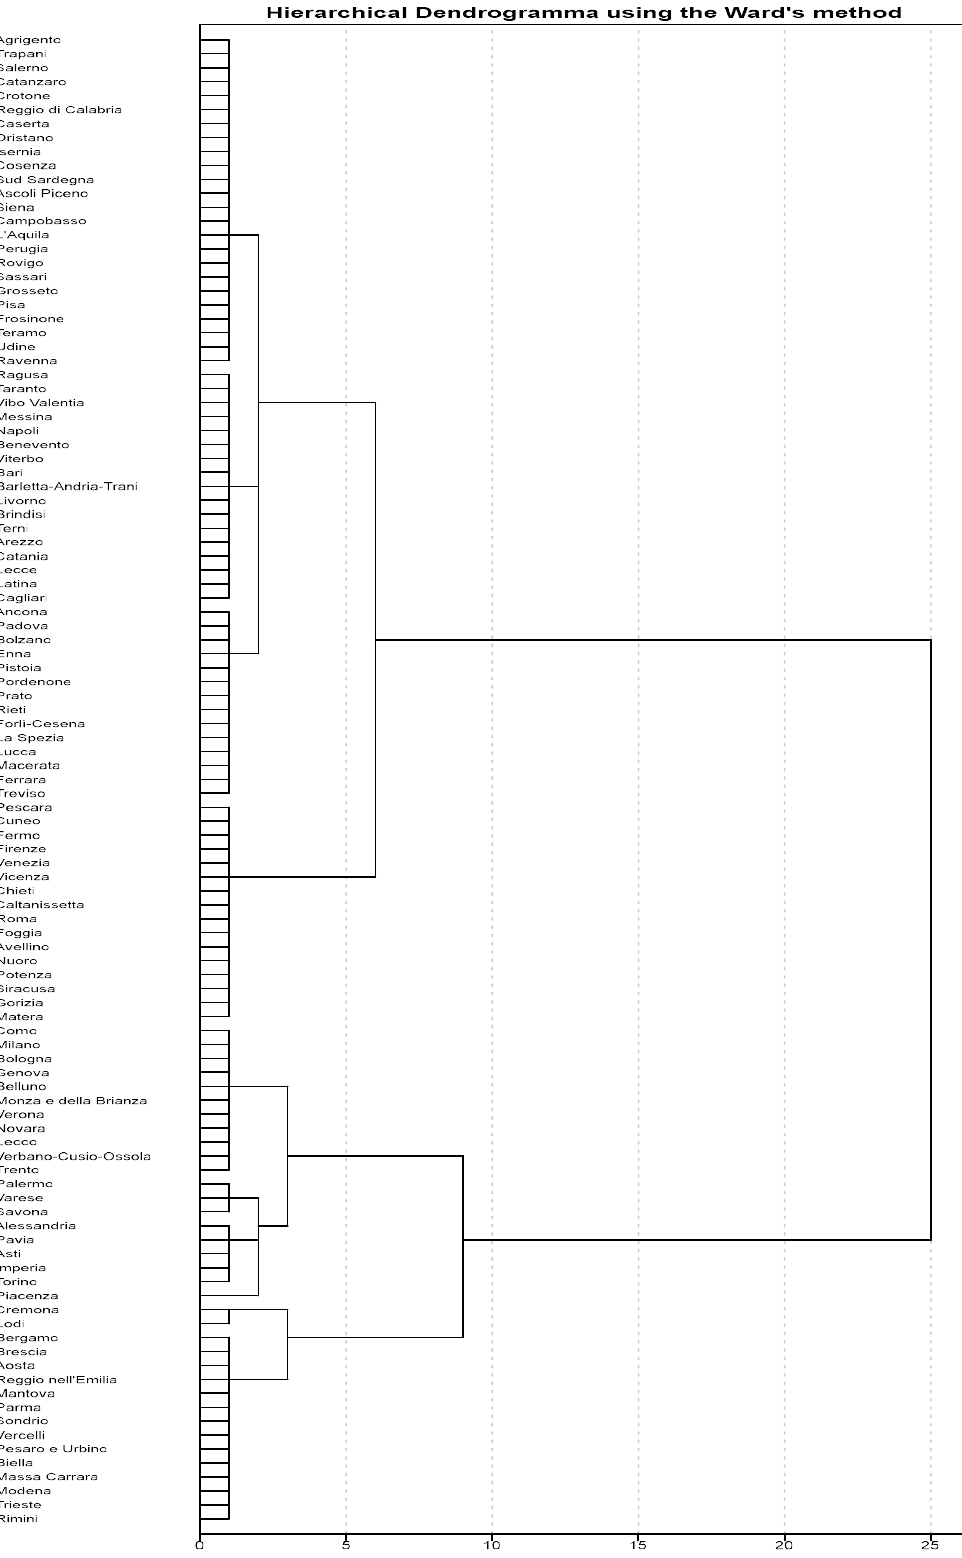
Figure 5. Dendrogram of the hierarchical clustering of the provinces based on Ward’s criterion.